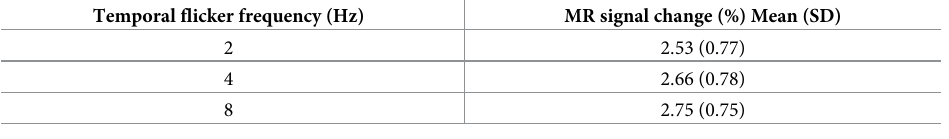
Table 1. Magnetic resonance (MR) signal change averaged within each region of interest and across all partici- pants (n = 29). Temporal flicker frequency (Hz)